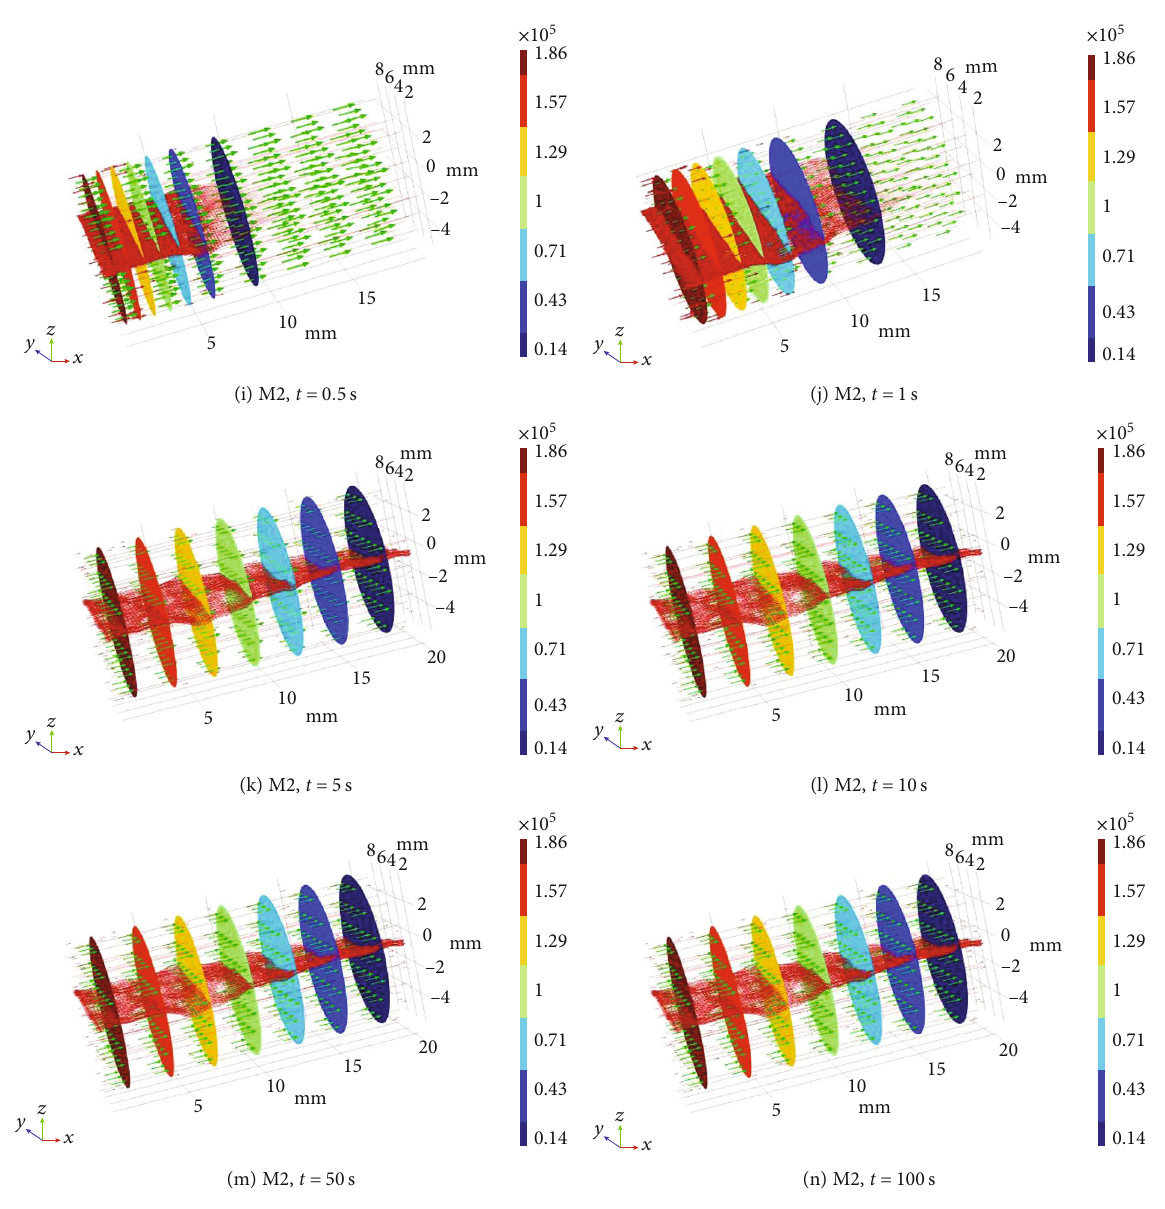
Figure 9: Variations of fl ow streamlines in the pore-fracture combination